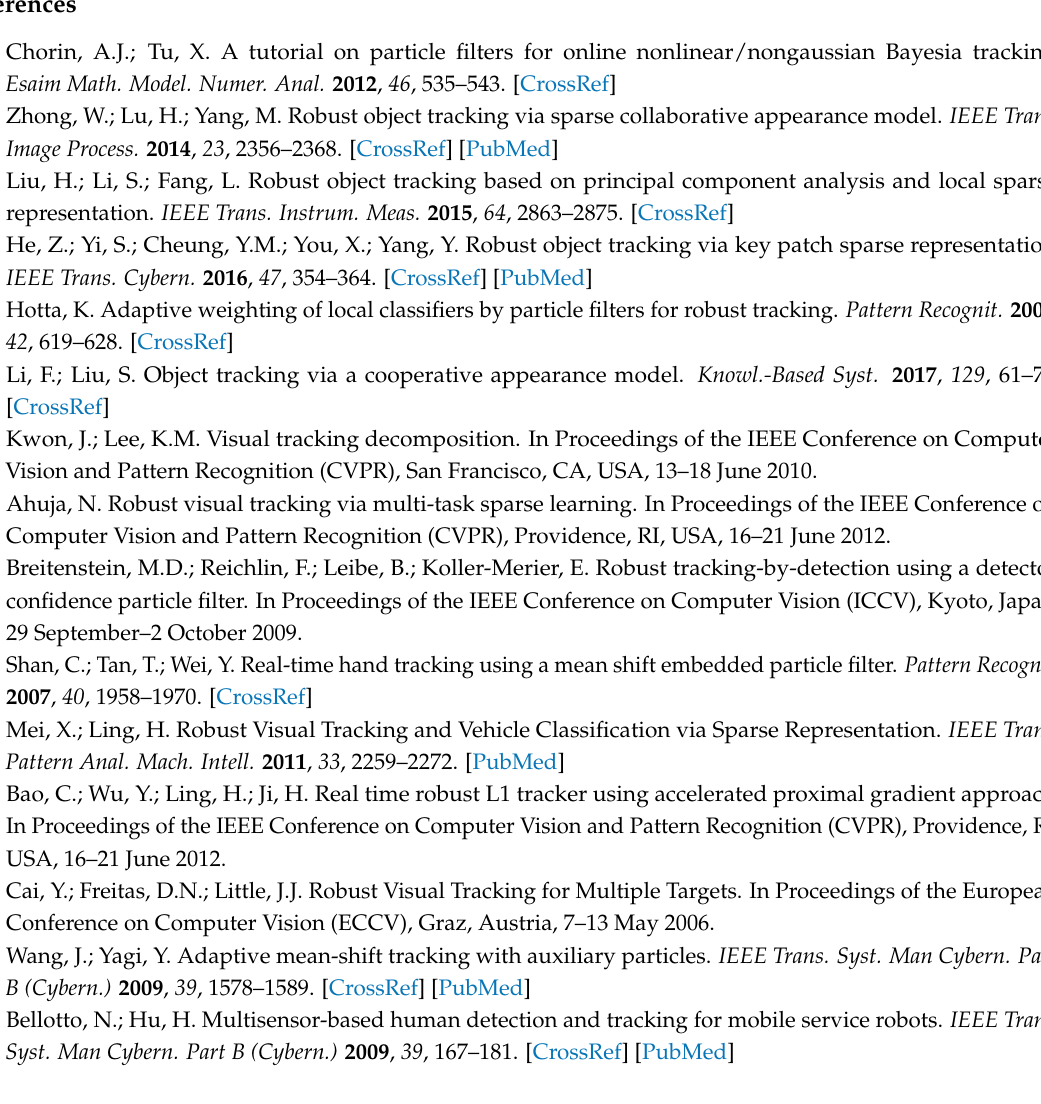
S1: Figure 9-Boy, Video S2: Figure 10-Coke, Video S3: Figure 11-Jogging-1, Video S4: Figure 12-Football, Video S5: Figure 13-Basketball, Video S6: Figure 14-Sylester, Video S7: Figure 15-Skating1, Video S8: Figure